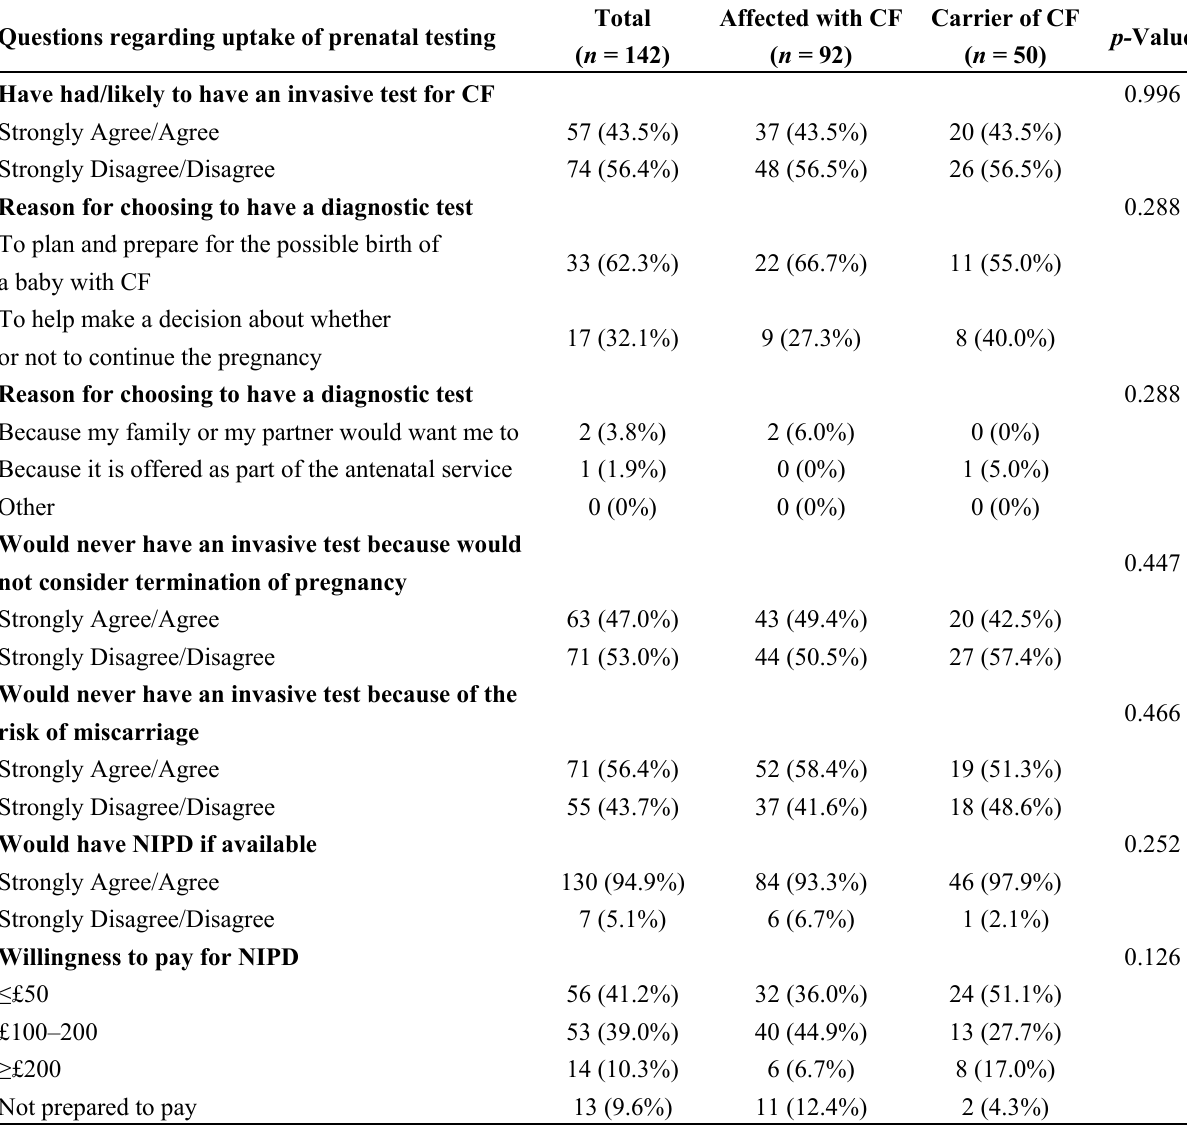
Table 4. Service user uptake of prenatal testing. NIPD, non-invasive prenatal